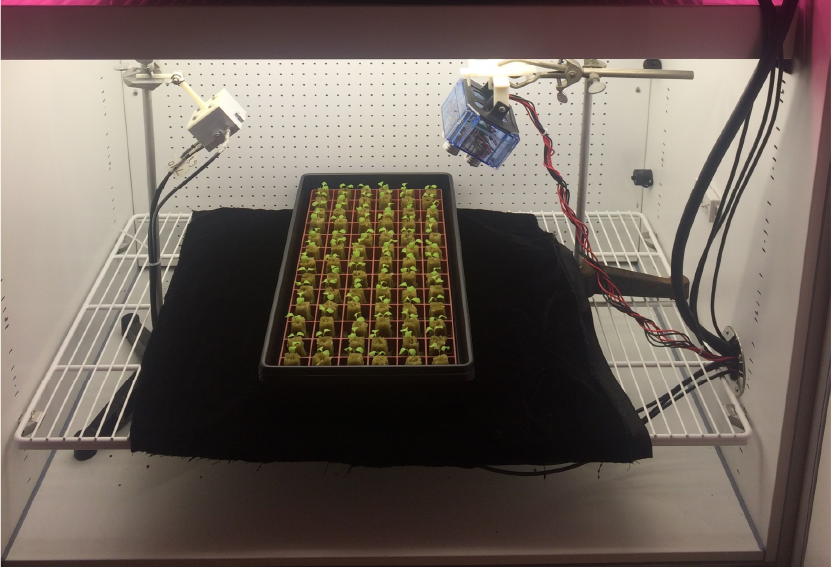
Figure 1. The excitation light source (right hand side) and the photodiode unit (left side) measuring ChlF of red lettuce in an controlled environment growth chamber. The individual components are described in more detail in the following